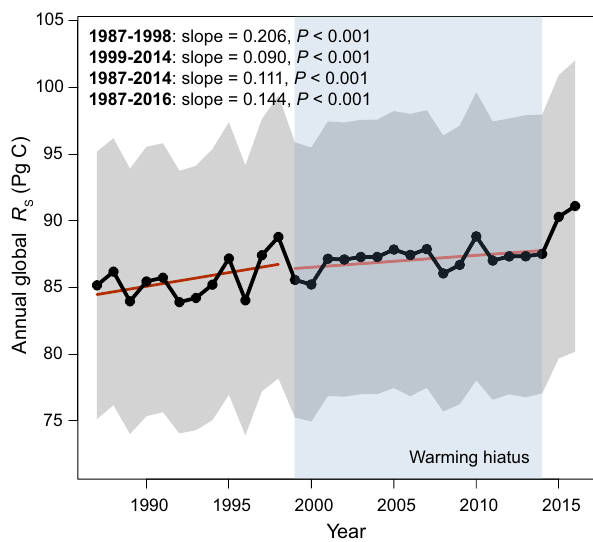
Fig. 4 Estimated annual global R S . Slopes and signi fi cances of linear regressions between annual global R S from 1000 Monte Carlo trials and year are shown. Regression lines of R S for the year in 1987 – 1998 and 1999 – 2014 are shown in red. The gray region denotes the standard deviations of annual global R S from Monte Carlo simulations. The fi lled blue area denotes the hiatus period of global warming (i.e., 1999 –